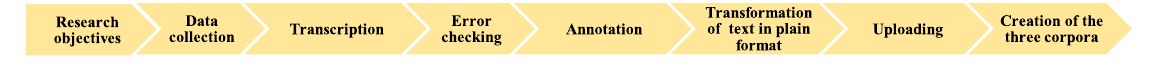
FIGURE1 Stages in the development of